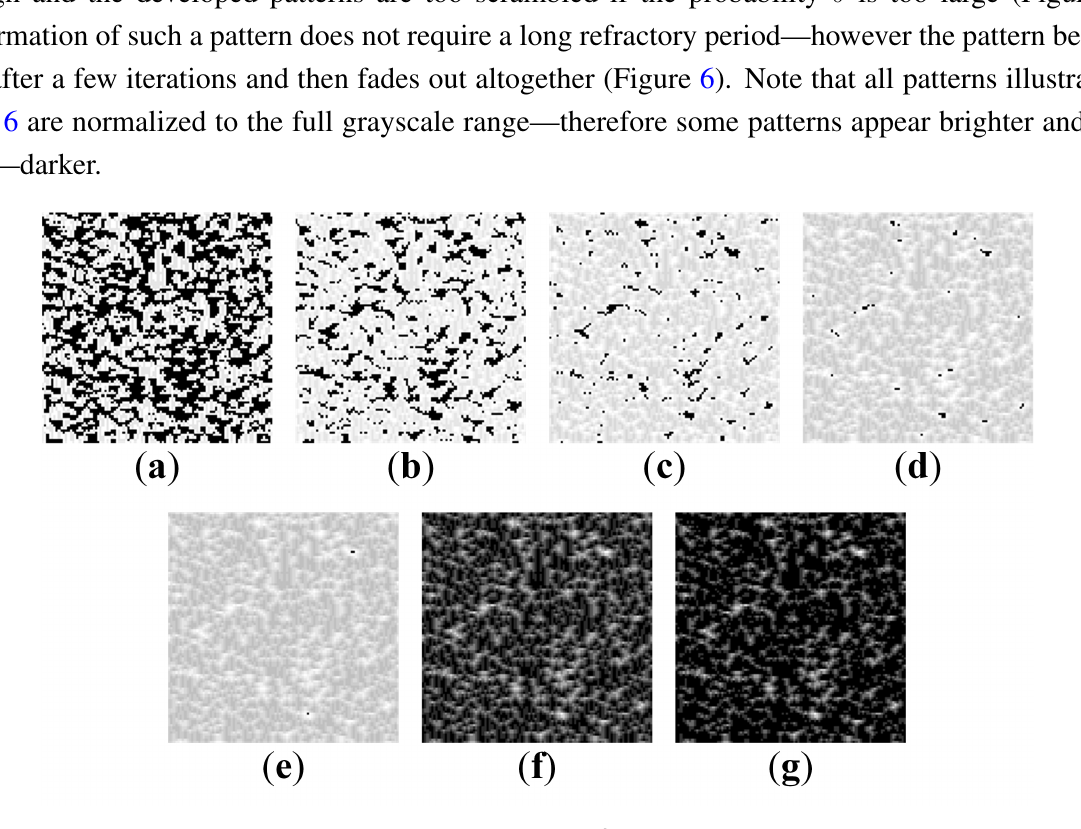
Figure 6. Iterative processes at ν = 0 . 5 , τ = 10 , δ = 0 . 1 . ( a ) n = 1 ( b ) n = 2 ( c ) n = 3 ( d ) n = 4 ( e ) n = 5 ( f ) n = 6 , 7 , 8 , 9 , 10 ( g ) n = 11